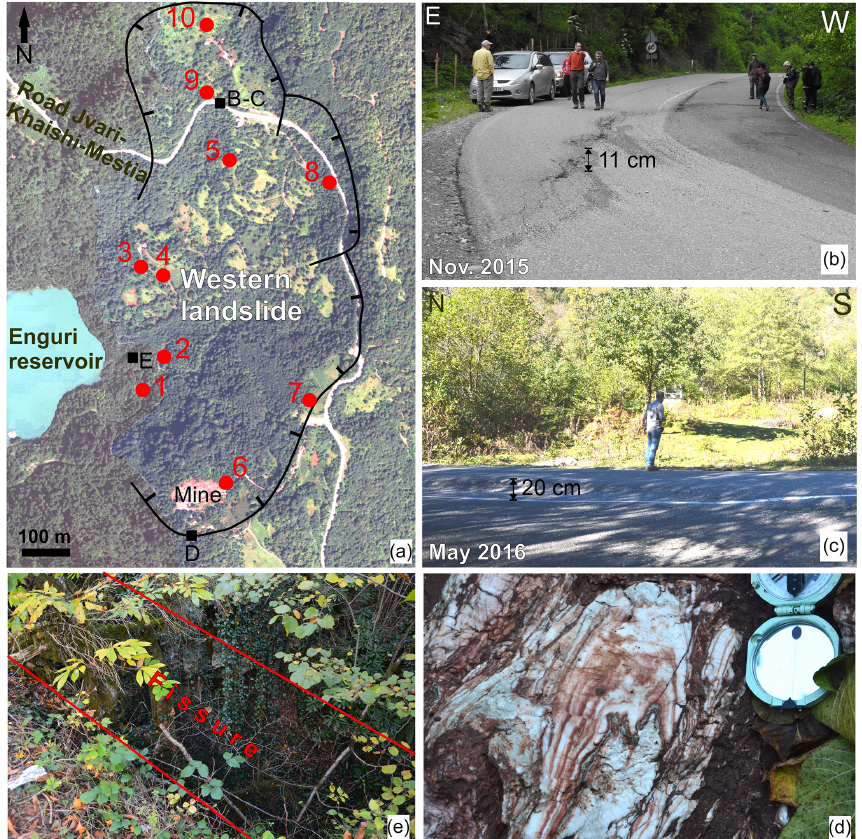
Figure 6. (a) Black lines show the main head scarps of the unstable slope area facing the Enguri reservoir. Black boxes show the locations of panels (b–e) . Red dots show the location of piezometers discussed in the modeling section. Panels (b) and (c) show photos of one of the several slip planes that offset the Jvari–Khaishi–Mestia road, taken in November 2015 and May 2016, respectively; note the large increase of the offset. (d) Strongly deformed gypsum deposits located at the foot of the northern part of the unstable slope area. (e) NE–SW-striking fissure located at the head scarp of the southern part of the unstable slope